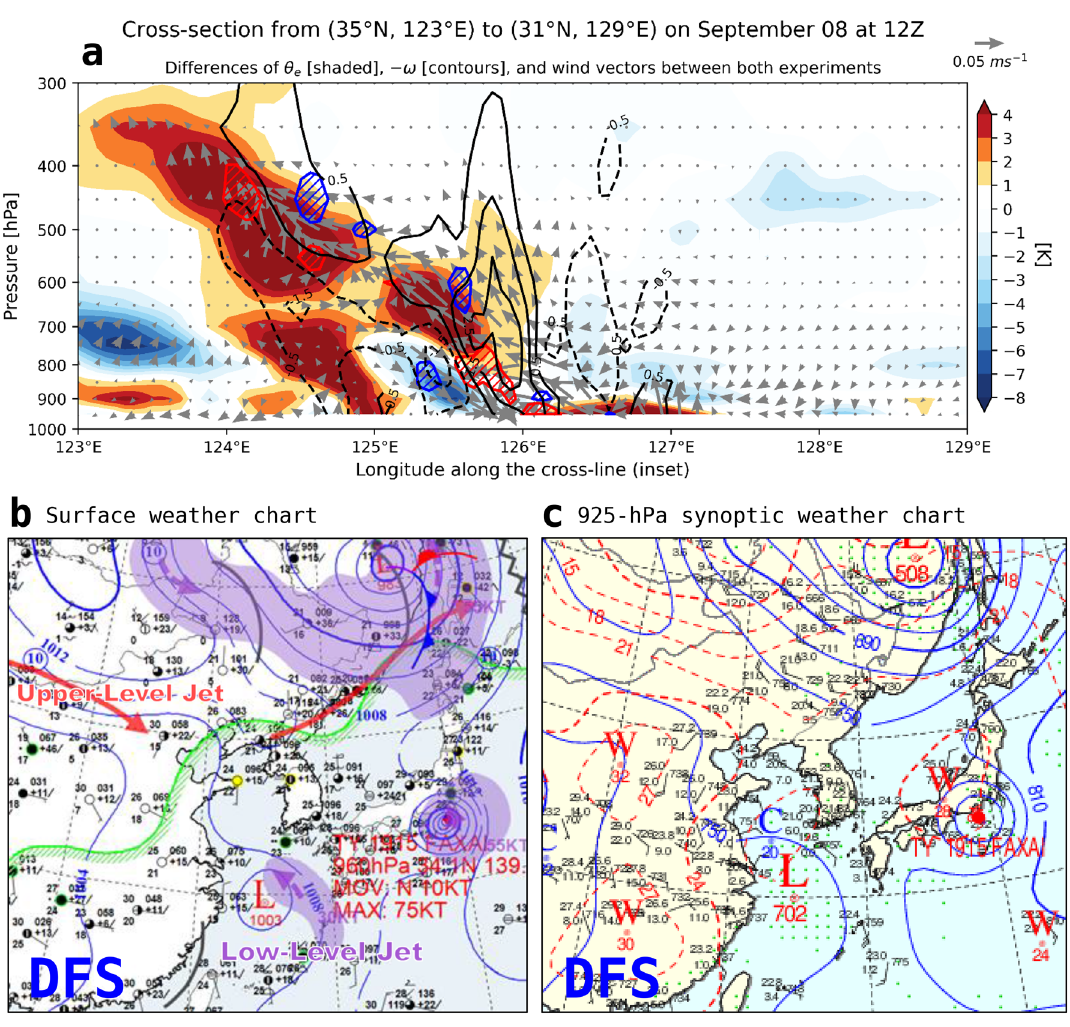
Figure 11. ( a ) Interpolated cross-section along the reference line on the lower-right panel of Fig. 10, ( b ) surface weather chart, and ( c ) 925 hPa synoptic weather chart on 8 Sep 2019, 12Z. The cross-section shows differences in equivalent potential temperature (shaded), vertical velocity (contours; intervals every 1 Pa/s), and moisture flux vectors. Positive shading denotes warmer air in the CPL simulation than that of the NOCPL simulation. The two weather charts in the lower panel were officially generated from the Digital Forecast System (DFS) in Korea Meteorological